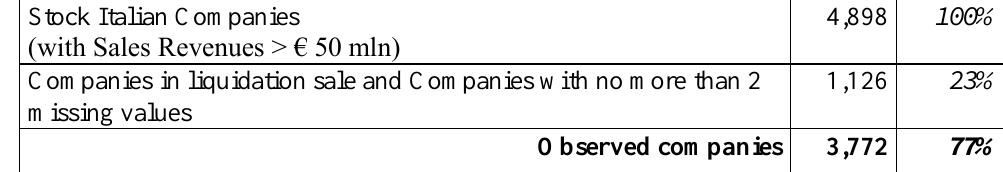
Table 1: Top Stock Italian Companies with Available Data